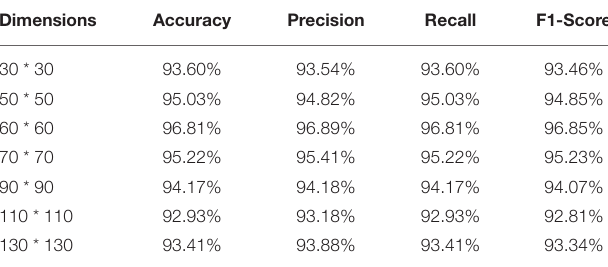
TABLE 6 | The performance evaluation results of different image